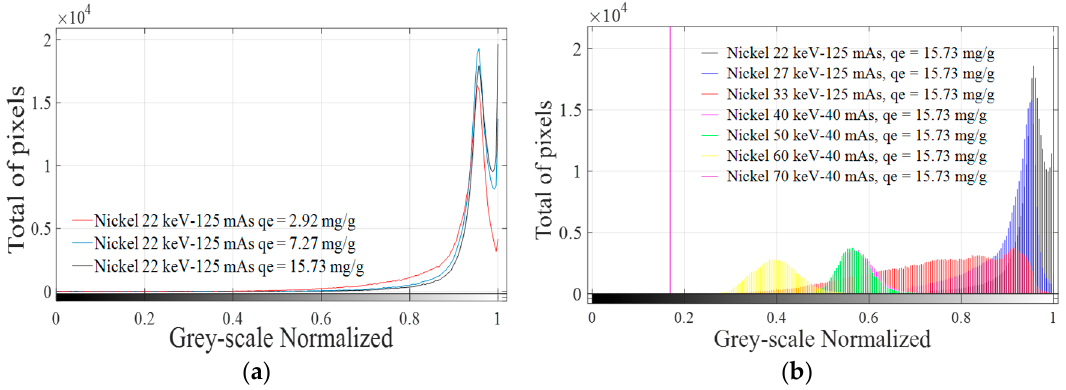
Figure 6. Combination of image histograms of nickel radiographies at: different q e values and constant energy (22 keV) ( a ); and different energies at the same q e value (15.73 mg/g) ( b ).